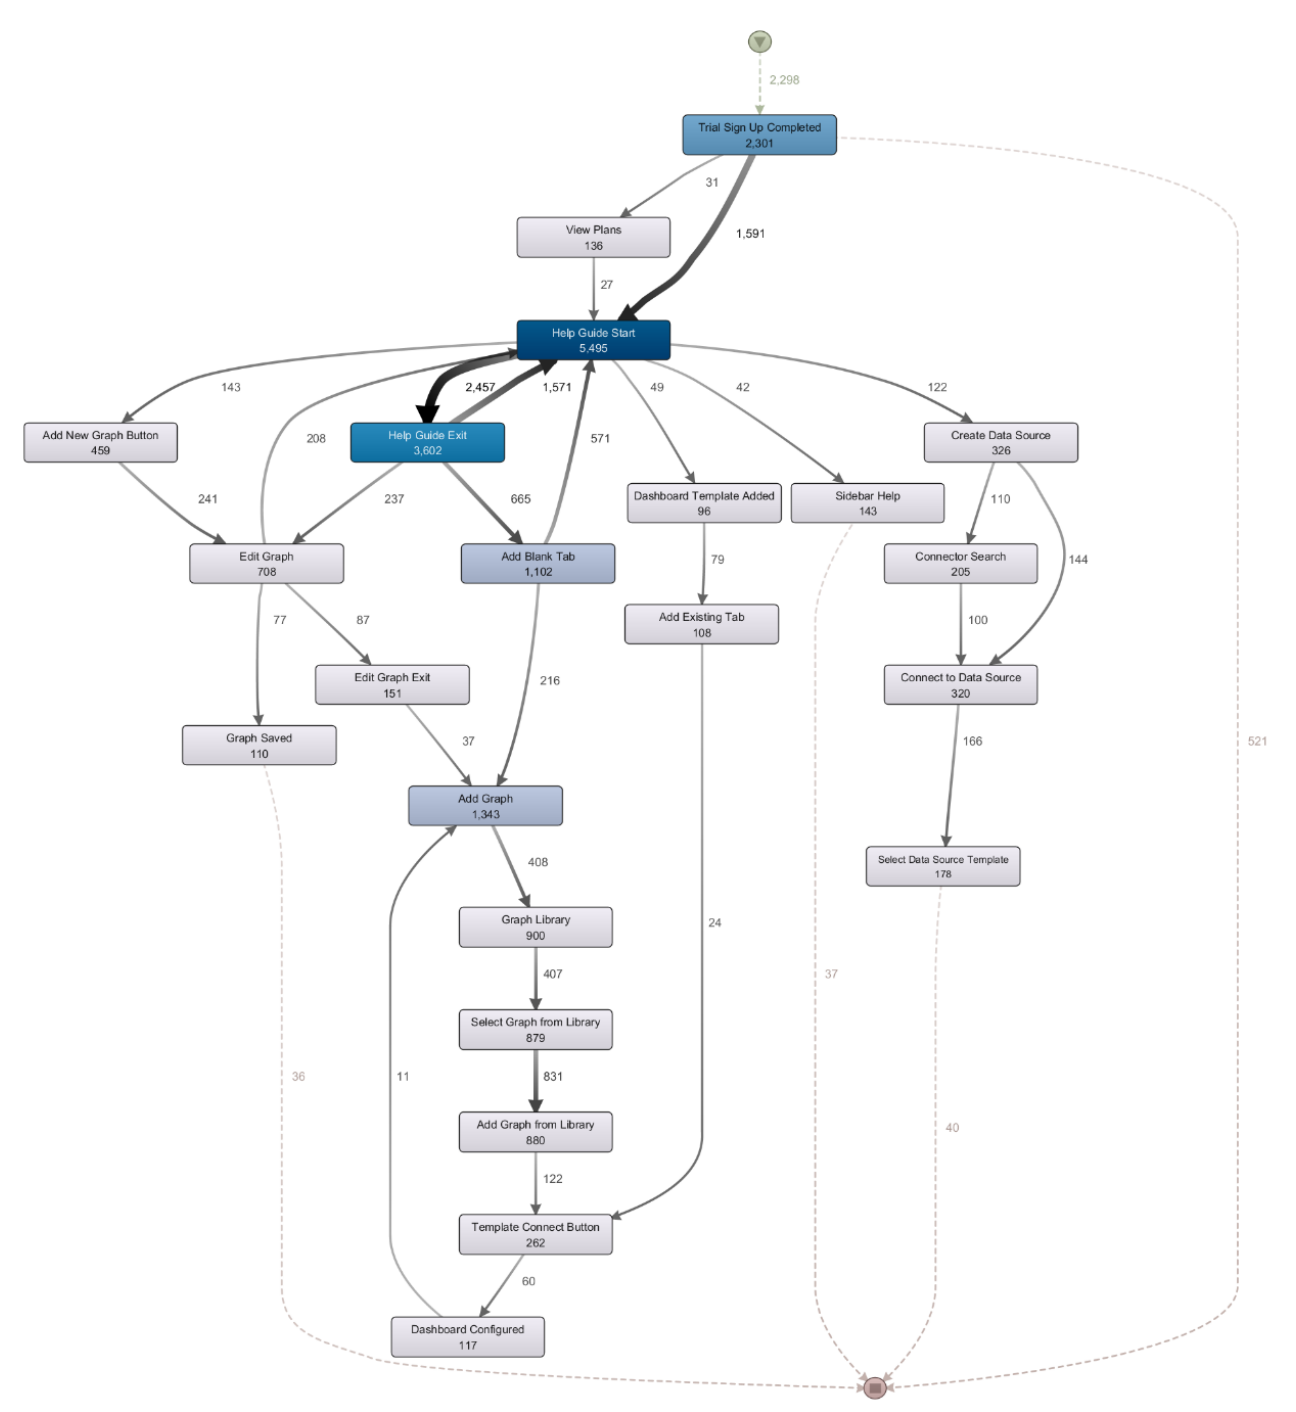
Figure 6. Process map for users who did not convert to customers within 5 min, generated with Disco from an event log with 2301